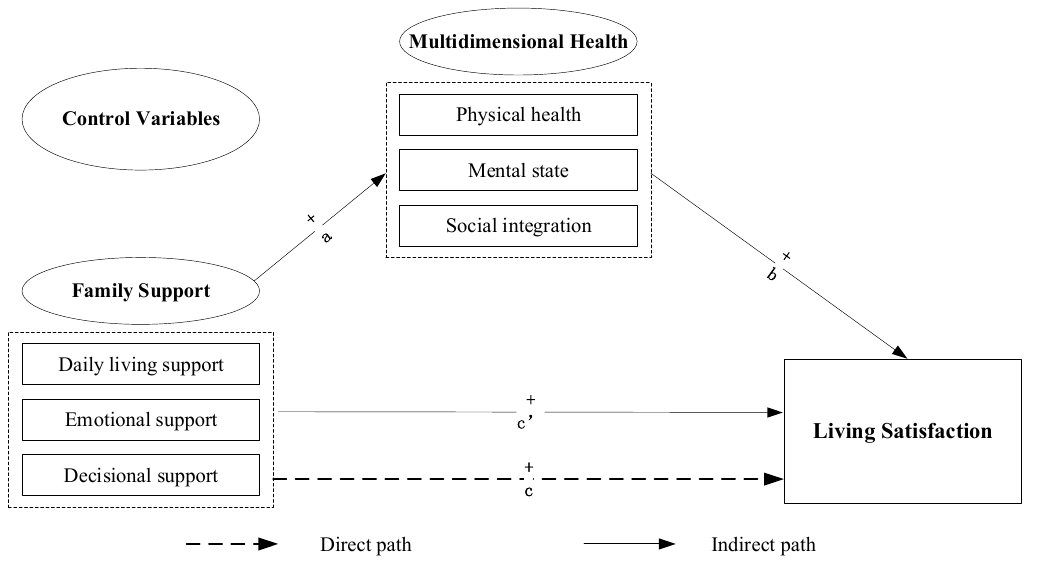
Figure 1. The conceptual mediation model relating to the family support, health, and life satisfaction of elderly individuals.